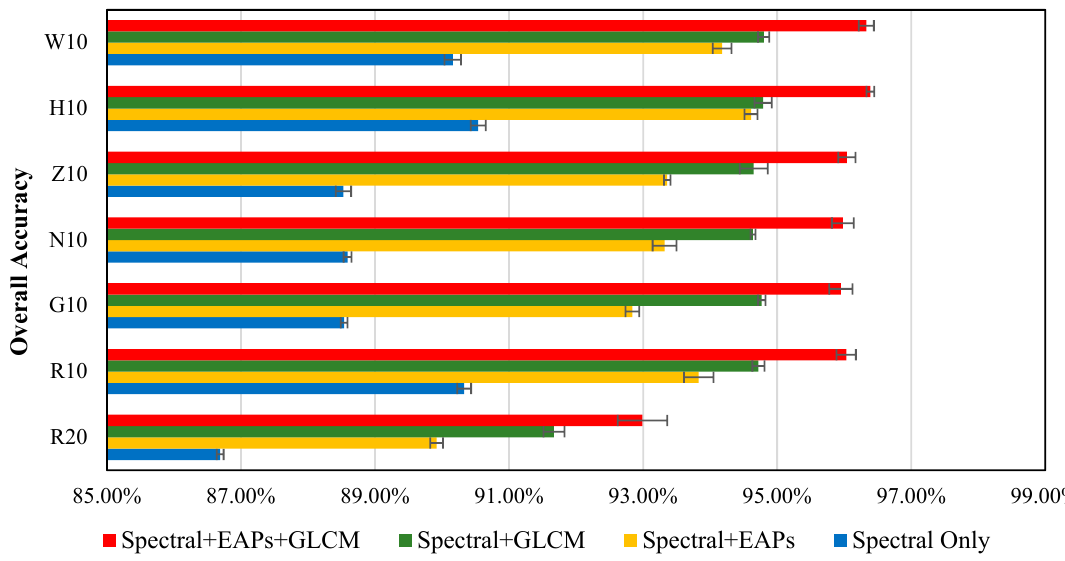
Figure 3. Overall accuracy of seven preprocessed images on each of the feature sets.